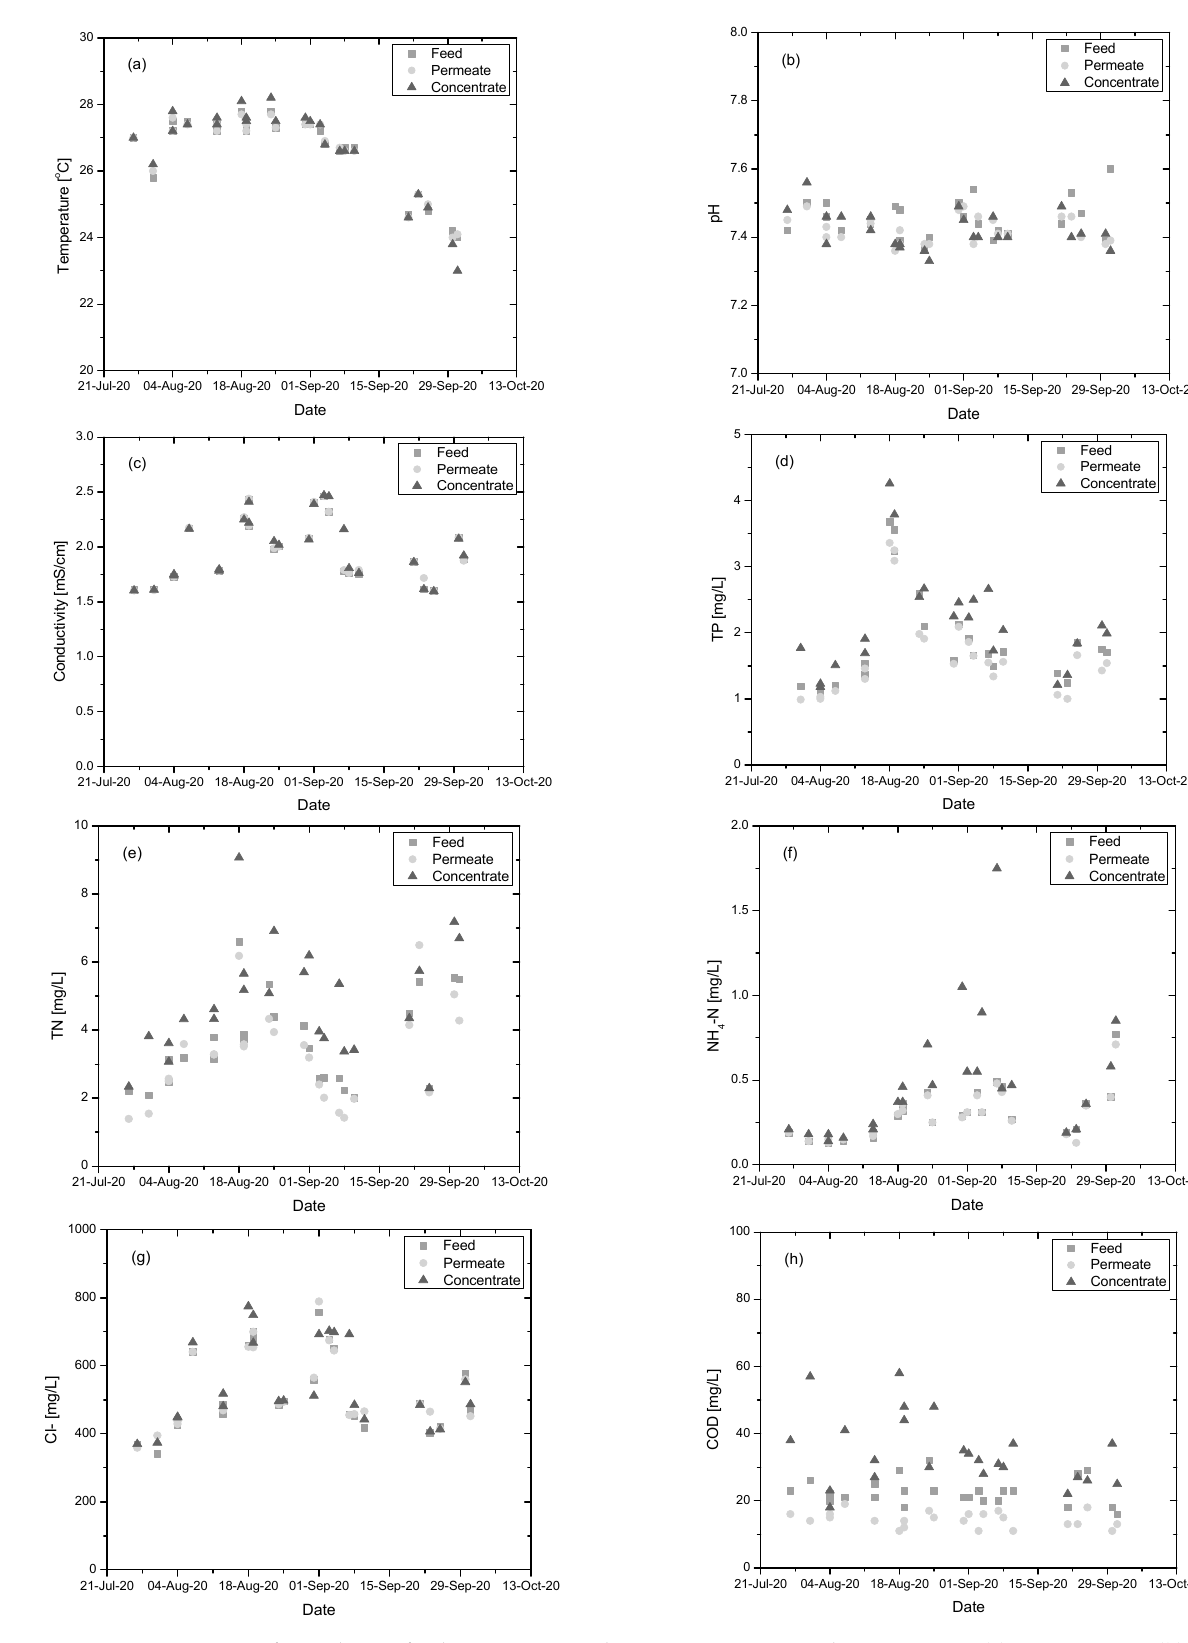
Figure 4. Monitoring of membrane feed, permeate, and concentrate stream characteristics: ( a ) temperature, ( b ) pH, ( c ) conductivity, ( d ) TP, ( e ) TN, ( f ) NH 4+ -N, ( g ) Cl, and ( h ) COD.